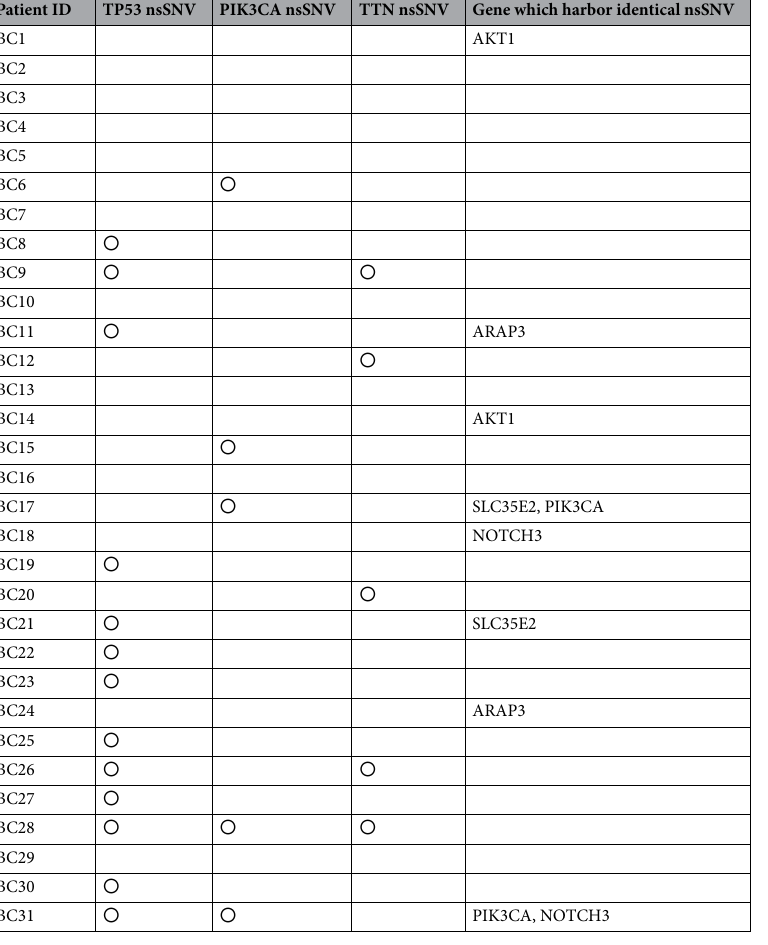
Table 2. Frequently mutated genes and genes that harboured identical nsSNVs. ○ : Patient with mutation. nsSNV: nonsynonymous single nucleotide